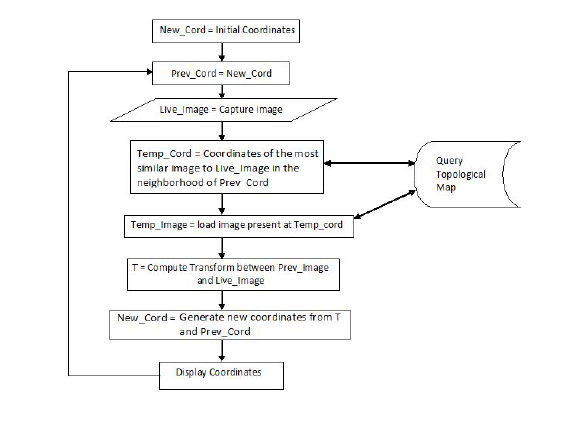
Figure 12: Flowchart of combined approach. The results of experi- ence based localization gives discrete coordinates. These coordi- nates are mapped to some images in the dataset. This image and online image are inputs to visual odometry which gives the final output pose of the